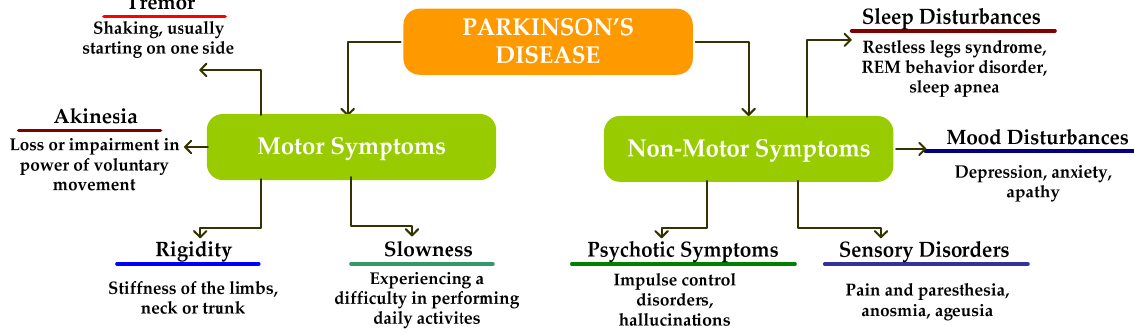
Figure 8. Categorization of Parkinson’s disease.